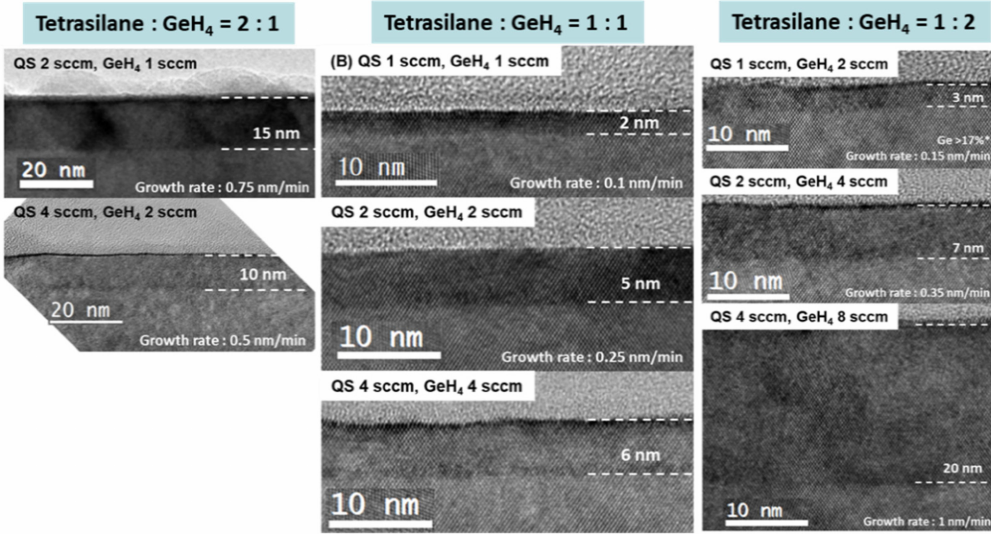
Figure 8. Cross-sectional TEM images of the SiGe epilayers grown using tetrasilane at 450 ◦ C. The tetrasilane and germane ratios were 2:1, 1:1, and 1:2.